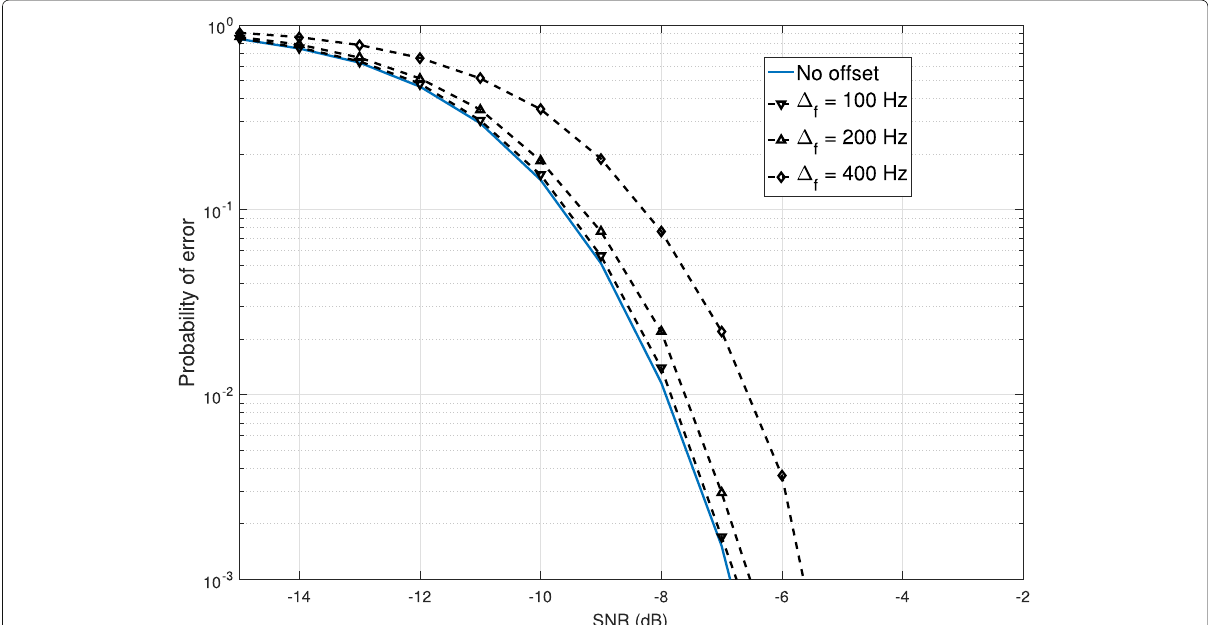
Fig.7 ErrorprobabilityversusSNR(dB)ofthesuggestedDFT-basedimplementation(15)assumingresidualfrequency offsets (cid:10) f ∈ { 100,200,400 }